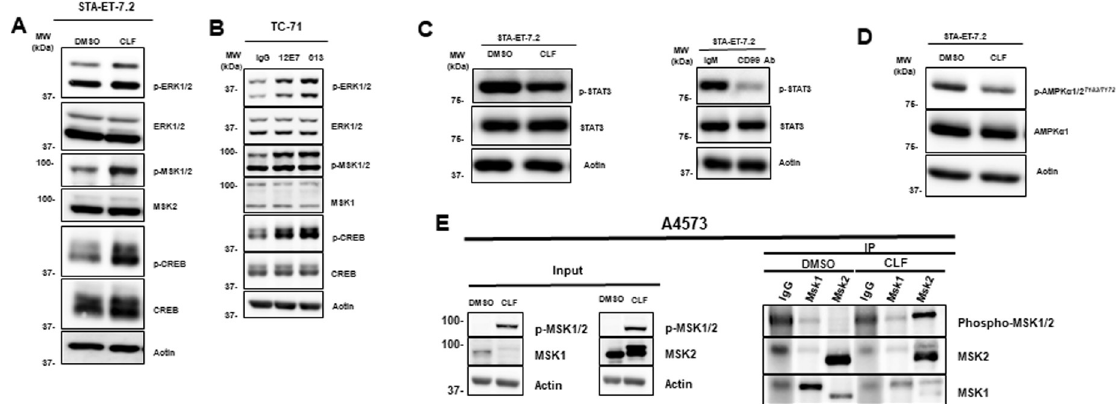
Fig 3. Clofarabine and CD99 antibodies cause specific protein phosphorylation in ES cell lines. (A) STA-ET-7.2 cells treated with clofarabine and western blot analyses were done by phosphospecific antibodies. Phosphorylation of ERK1/2, MSK1/2 and CREB levels were increased with clofarabine treatment; (B) TC-71 cells treated with two different C99 antibodies (15 μ g/ml) and phosphorylation changes were analyzed by immunoblotting. Similar to clofarabine treatment, phosphorylation of ERK1/2, MSK1/2 and CREB were increased; (C, D) STA-ET-7.2 cells treated with clofarabine, CD 99 antibody and decreased phosphorylation changes for STAT3 and AMPK α 1 were validated by western blotting; (E) A4573 cells treated with clofarabine show increased level of pMSK1/2 and main phosphorylated protein is pMSK2.